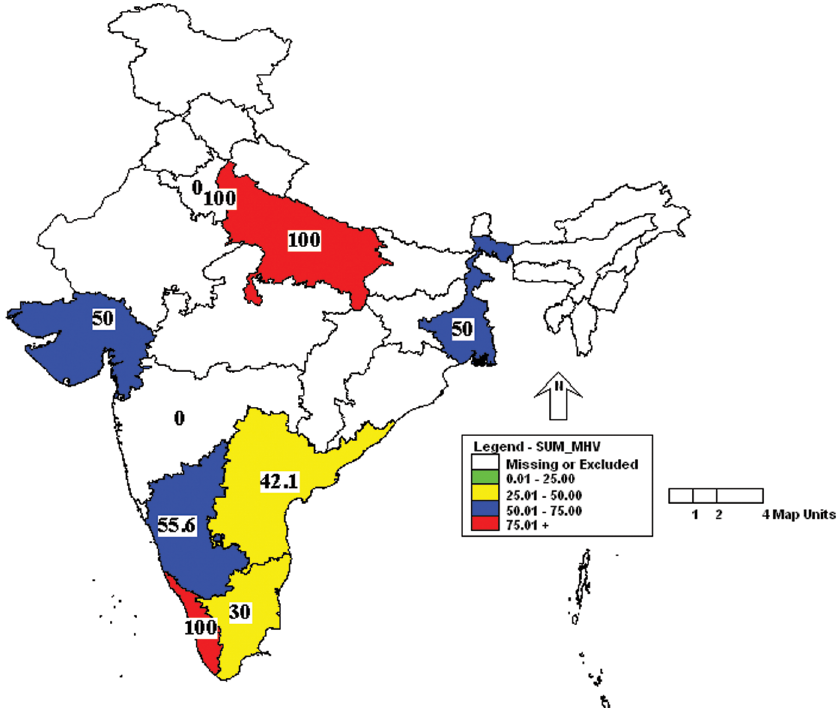
Fig 1. Incidence of mouse hepatitis virus (MHV) in different states of India. Yellow — 25.01 to 50.00%; Blue — 50.01 to 75.00%; Red — 75.01 to 100.00%.